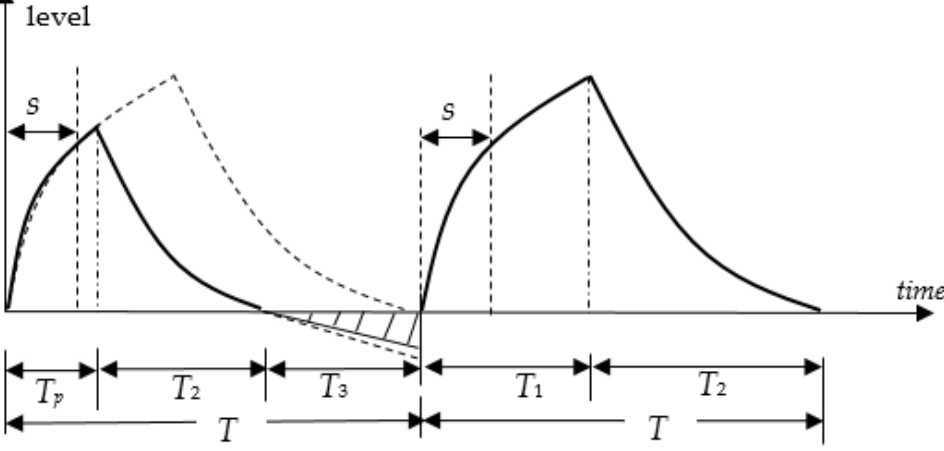
Figure 2. Production inventory level with machine breakdown, inspection, and partial backordering.